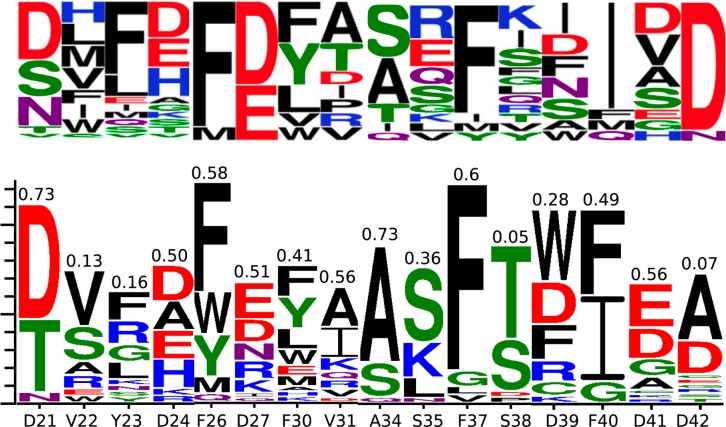
Comparison of phage display results (top) and Rosetta predictions (bottom) for optimal VEGF binding using canonical amino acids.Similarity to phage display is annotated above each logo column (Pearson correlation). Phage results are adapted from figure 2D of Mandal et al[26].